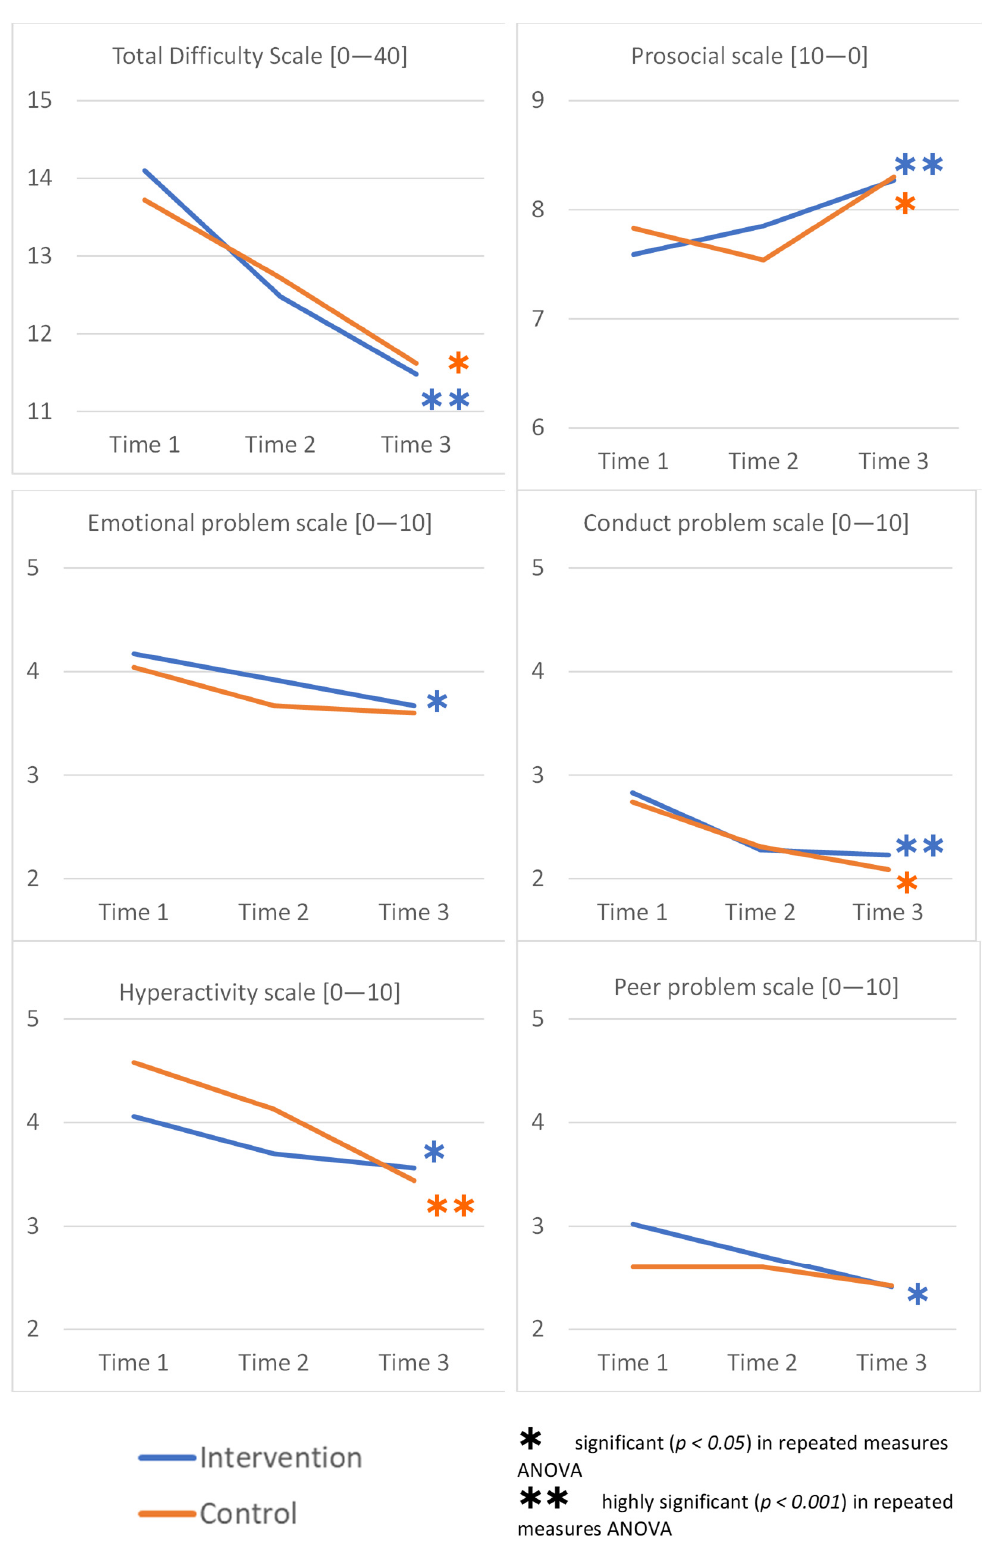
Figure 4. Overall SDQ results comparing intervention and waitlist/control group ( higher scores indicating higher levels of difficulties on all subscales and the Total Difficulty Scale, except for the prosocial scale where higher scores indicate fewer